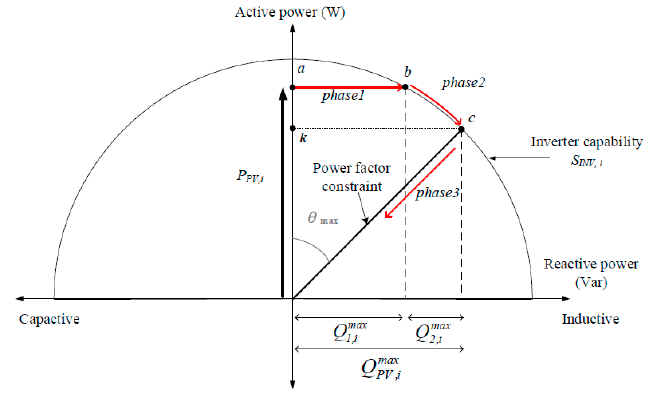
Figure 1. The Watt-Var control scheme of a smart PV inverter.